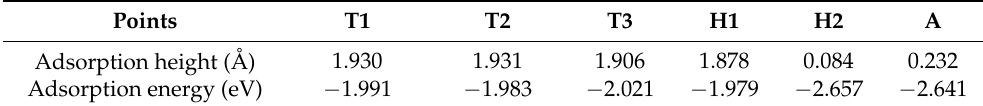
Table 3. Adsorption height and adsorption energy of six points for